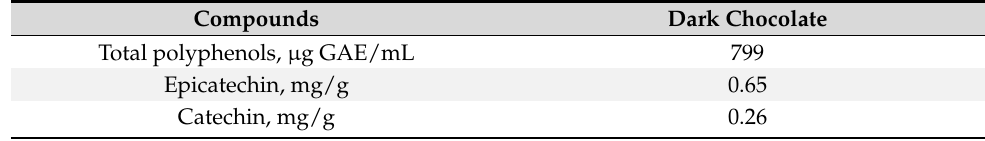
Table 3. Total Polyphenols Content in Dark Chocolate.